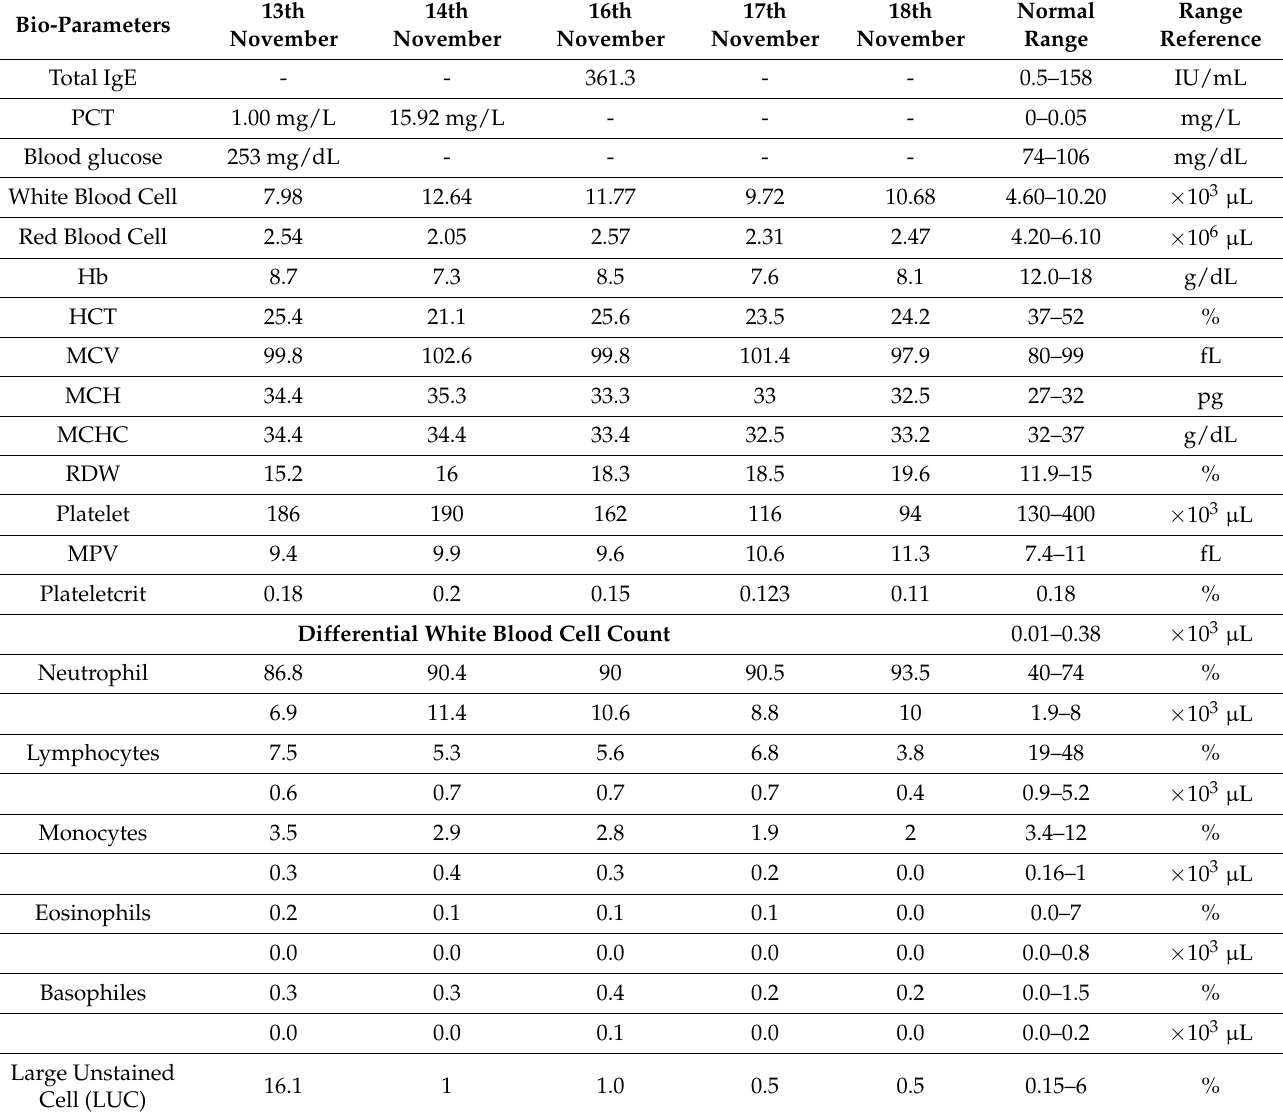
Table 1. Clinical biochemistry profile, recorded during hospitalization (13 November 2021, admission; 18 November 2021, exit; Hb, hemoglobin; HCT, hematocrit test; MCV, mean cell volume; MCH, mean corpuscular hemoglobin; MCHC, mean corpuscular hemoglobin concentration; RDW, red cell distribution